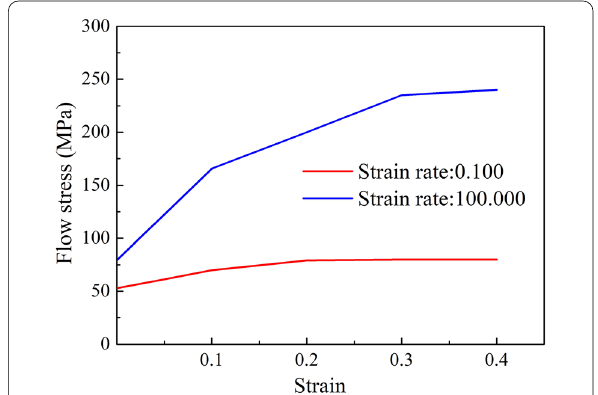
Figure 2 The constitutive model of